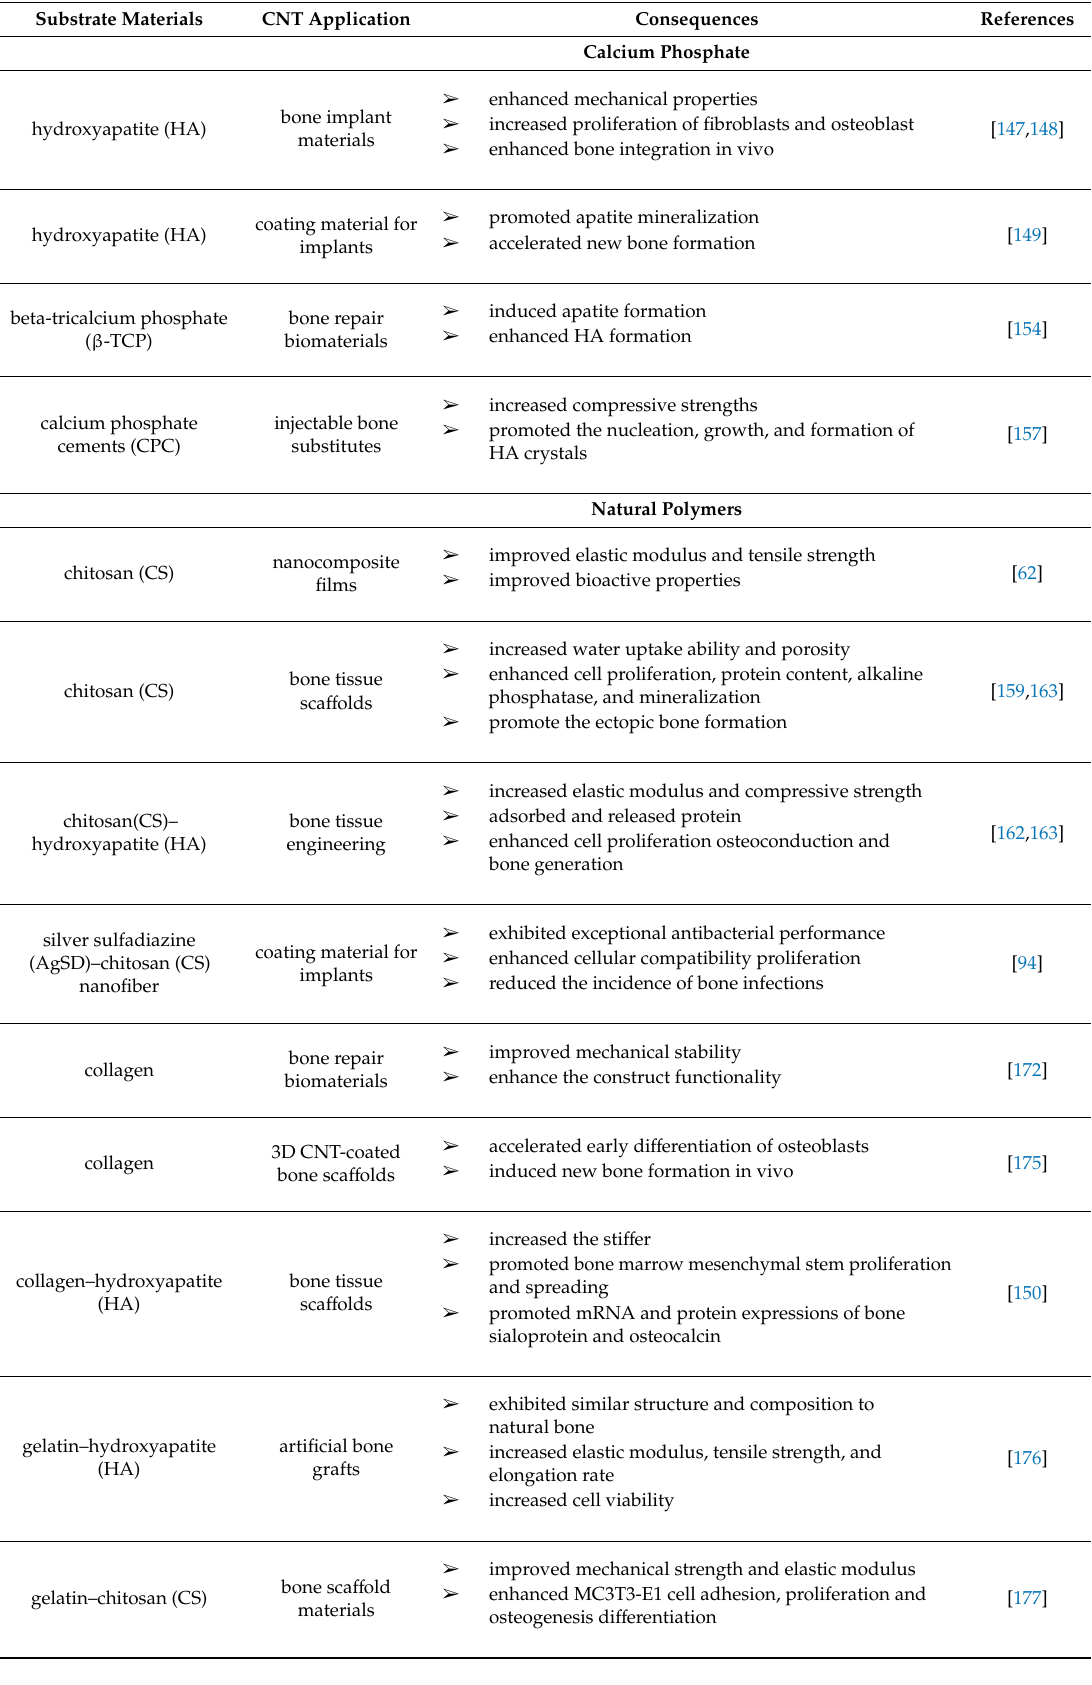
Table 1. Applications of CNT-based nanomaterials as sca ff olds or implants in bone tissue. Substrate